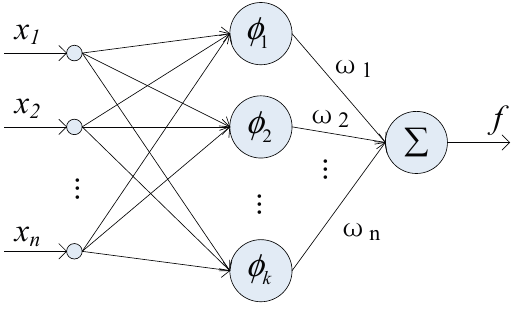
Figure 5. The structure of the RBF